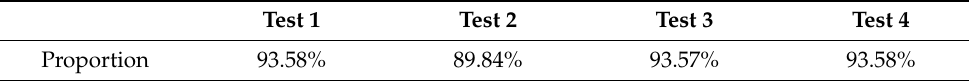
Table 3. The proportion satisfying the constraints.